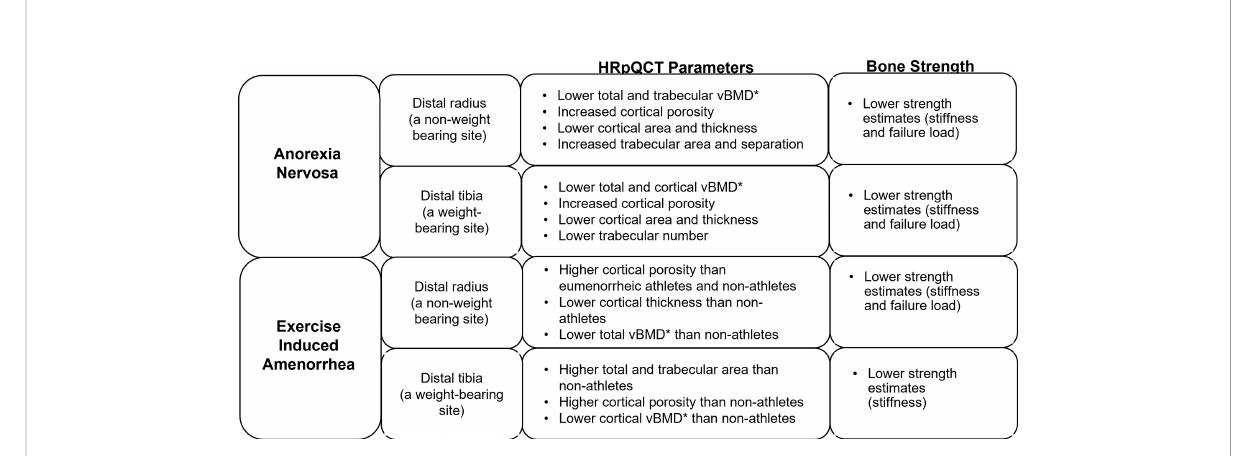
FIGURE 1 Impact of functional hypothalamic amenorrhea on bone parameters as assessed by high-resolution peripheral quantitative computed tomography (HRpQCT) and micro fi nite element analysis ( m FEA). HRpQCT was used to assess volumetric bone mineral density (vBMD)*, bone geometry and structure, and m FEA to assess bone strength estimates at the distal radius and